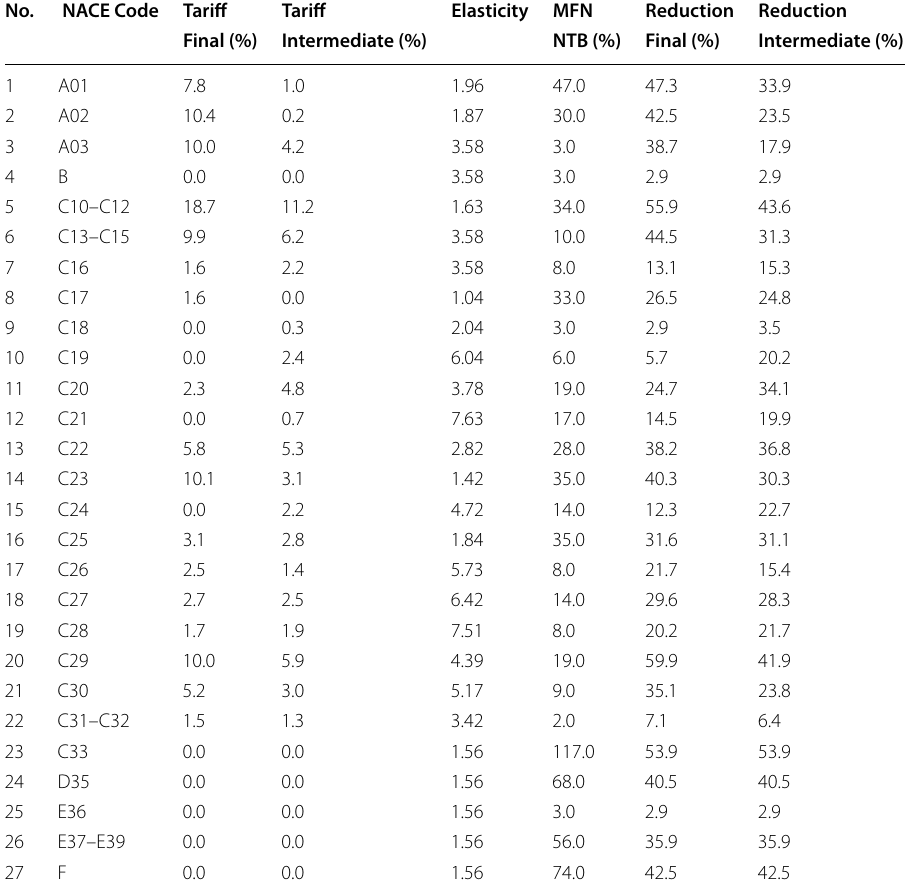
Table 8 Industry‑specific tariffs, elasticities, non‑tariff trade barriers, and reductions in trade volumes